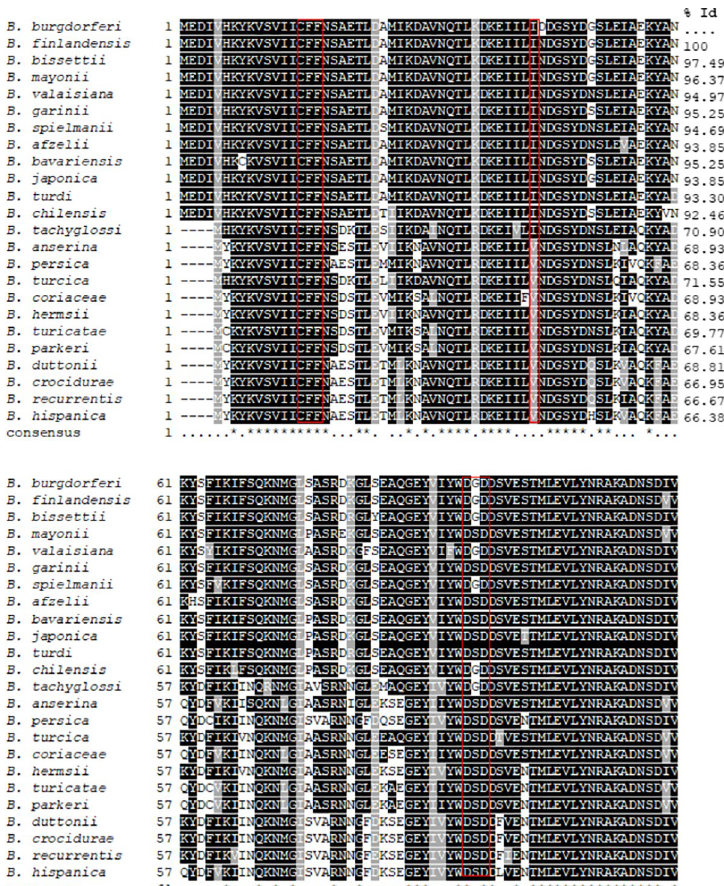
Fig 2. Multiple sequence alignment of the BB0572 sequence from Borrelia burgdorferi against Lyme disease and relapsing fever causing spirochetes. Red box indicates the active motifs of the GT2 glycosyltransferase enzyme. A star indicates positions which have a single, fully conserved residue. A period (.) indicates conservation between groups of weakly similar properties.